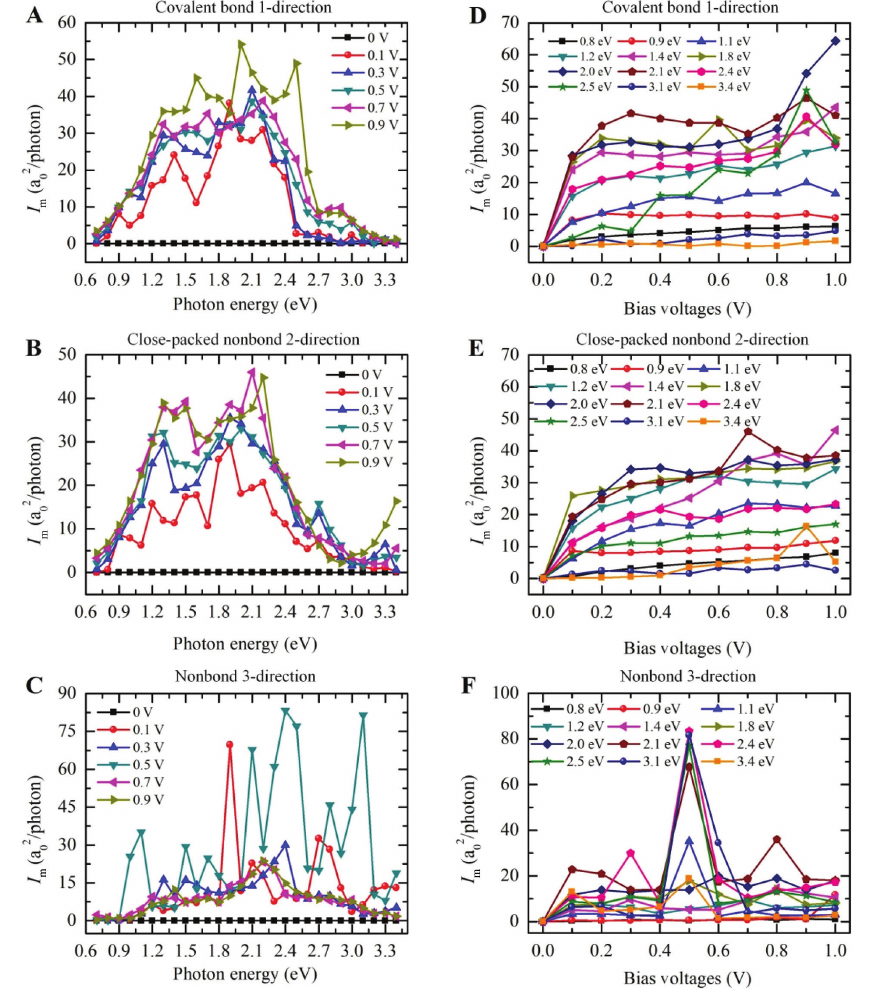
Figure 3: The dependence of maximum photocurrent on photon energy and bias voltage in bilayer tellurene. The maximum photocurrent as a function of (A–C) photon energy and (D–F) bias voltage in the covalent bond 1-, close-packed nonbond 2-, and nonbond 3-directions of bilayer tellurene,